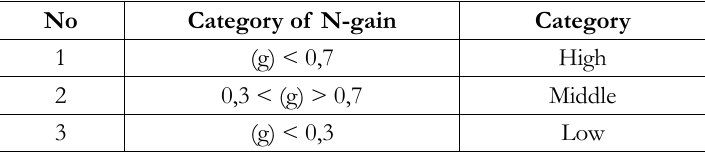
Table 2. Normalized gain criteria (Hake,